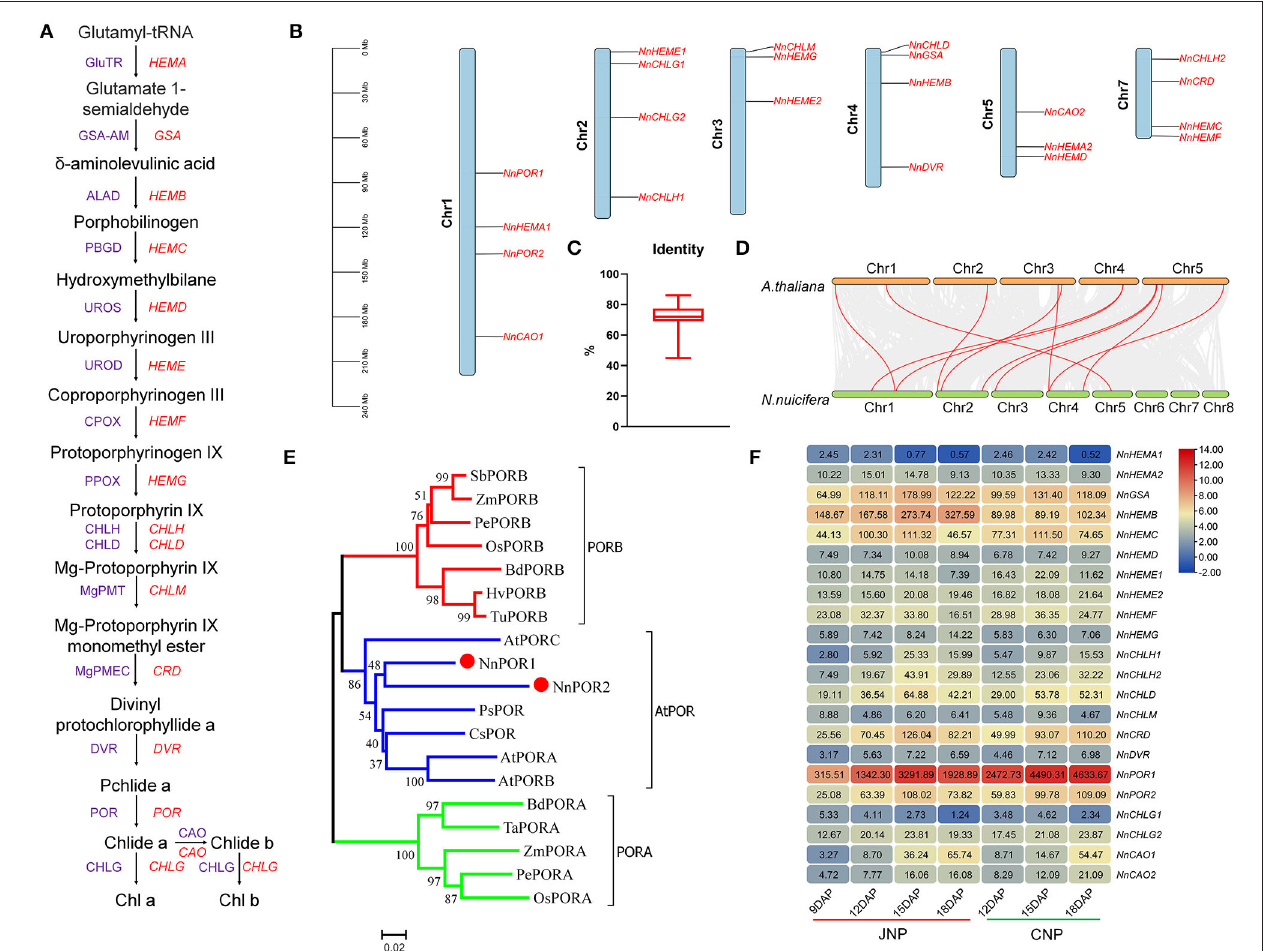
FIGURE 4 | Genome-wide identification and expression analysis of Chl biosynthesis genes in lotus. (A) Chl biosynthesis pathway in higher plants. Purple and red letters represent enzymes and genes, respectively. (B) Chromosomal localization of Chl biosynthesis genes in lotus. (C) The amino acid sequence identity between Arabidopsis and lotus Chl biosynthesis genes. (D) Synteny analysis of Chl synthesis genes between Arabidopsis and lotus. (E) Phylogenetic tree showing the relationship of lotus POR genes. GenBank Accession Number: SbPORB (XP_002467010.1), ZmPORB (NP_001149903.1), PePORB (PH01000789G0260), OsPORB (Q8W3D9.1), BdPORB (XP_003570527.1), HvPORB (Q42850.1), TuPORB (TuPORB), AtPORC (NP_001030948.1), PsPOR (CAA44786.1), CsPOR (BAA21089.1), AtPORA (AAC49043.1), AtPORB (NP_001031731.1), BdPORA (XP_010240614.1), TaPORA (Q41578.1), ZmPORA (NP_001167683.1), PePORA (PH01000087G0190), and OsPORA (Q7XKF3.1). (F) Expression patterns of Chl biosynthesis genes during lotus plumule